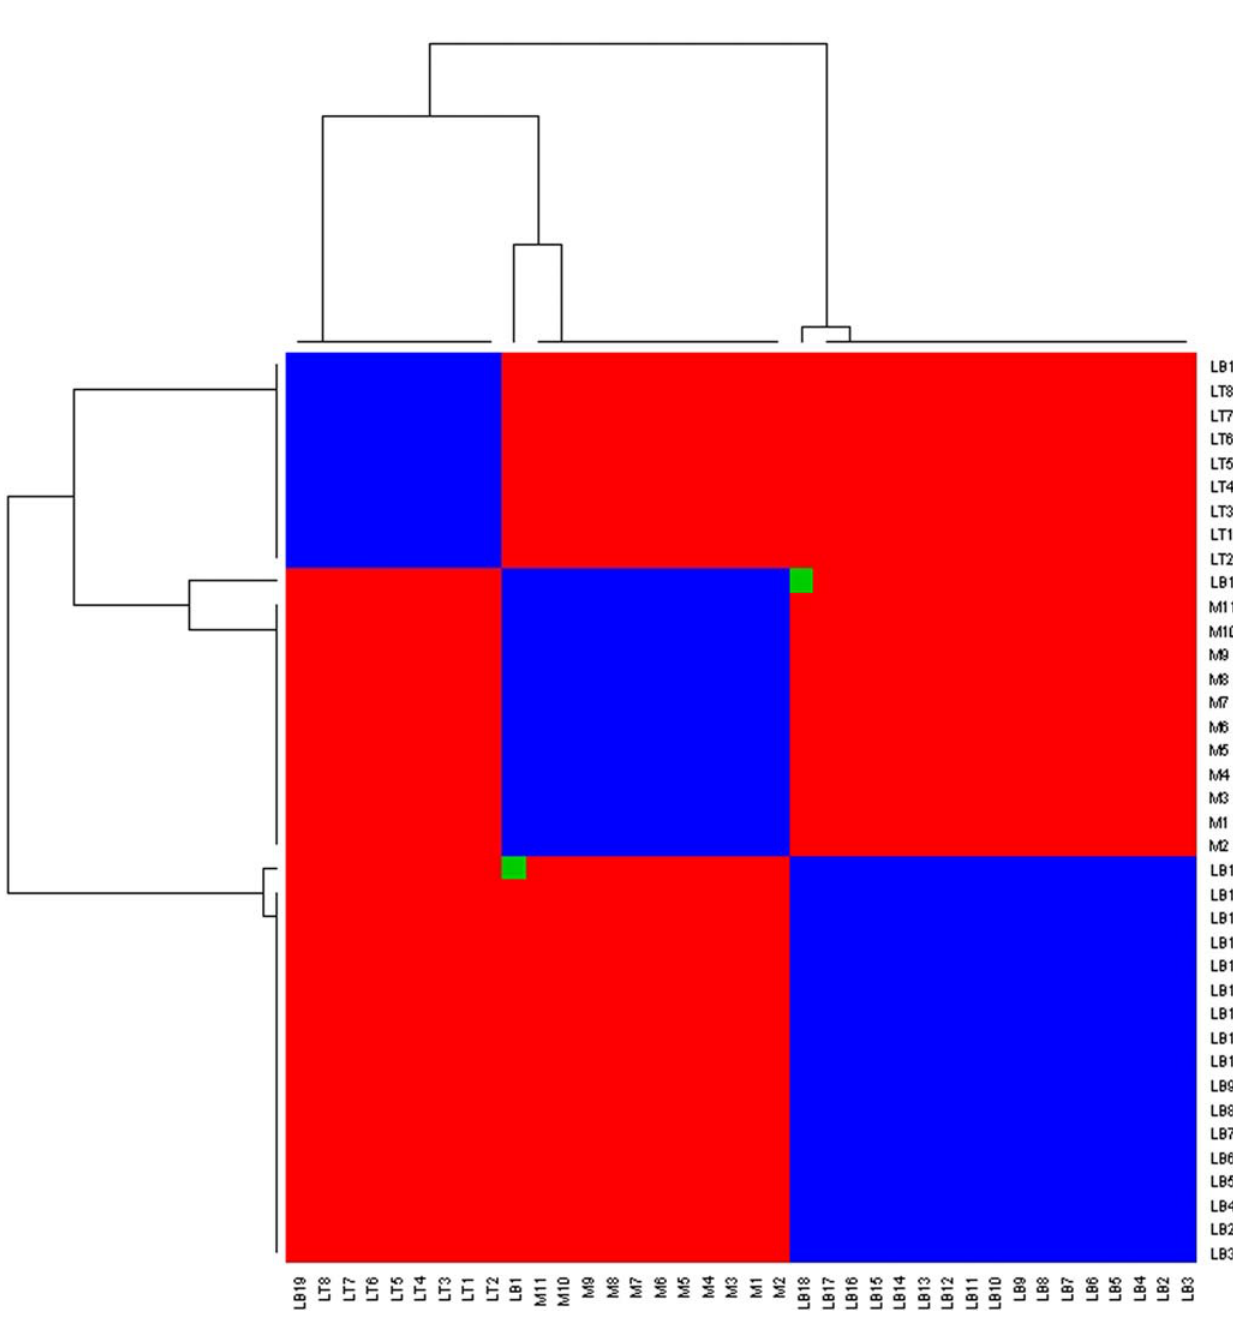
PLoS Computational Biology |